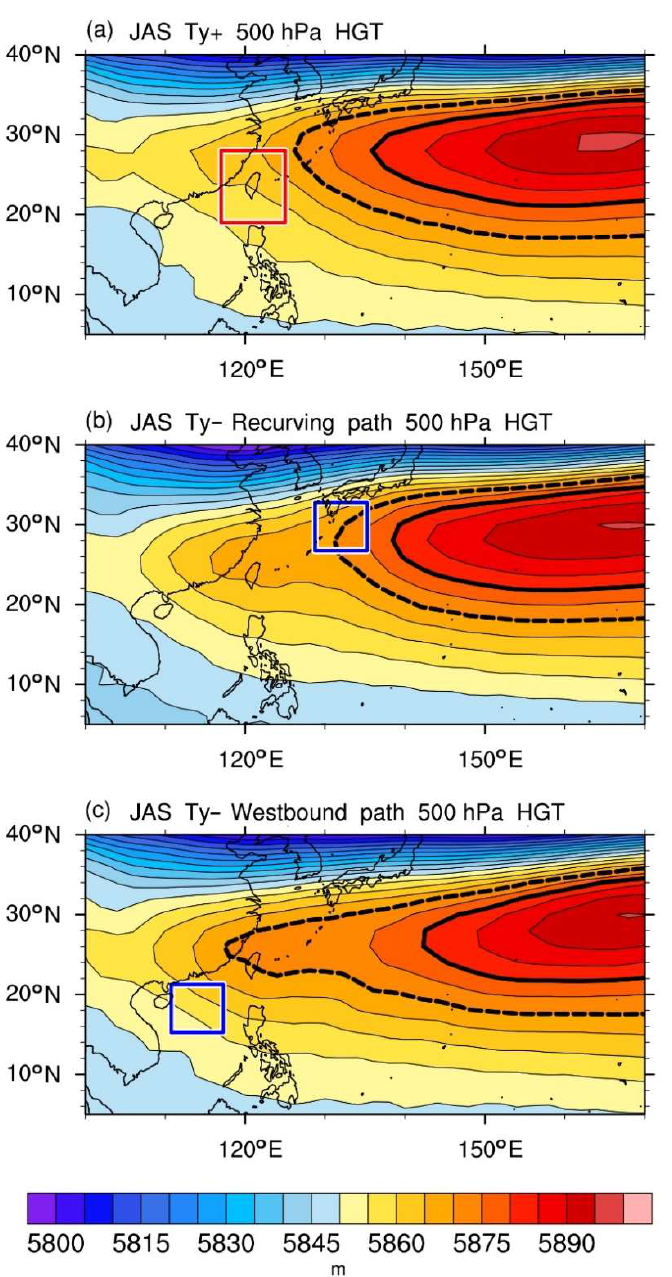
Figure 6. Geopotential height at 500 hPa (unit: m) for ( a ) the Ty + category, ( b ) the recurving path of the Ty − category, and ( c ) the westbound path of the Ty − category. The thick solid and dashed contours represent the 5880 m and 5870 m geopotential heights, respectively. The red box in ( a ) shows the typhoon verification domain A, and the blue boxes in ( b ) and ( c ) show the verification domains B and C for typhoon path categorization.